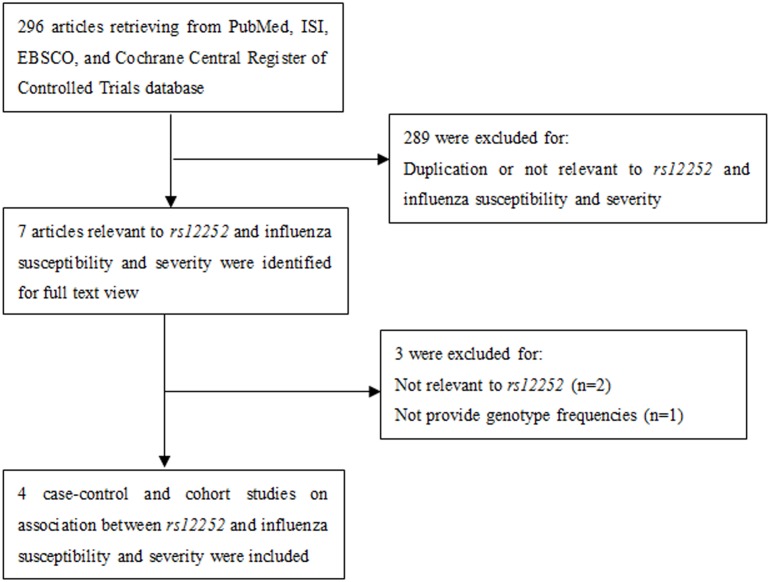
Flow chart of data selection.